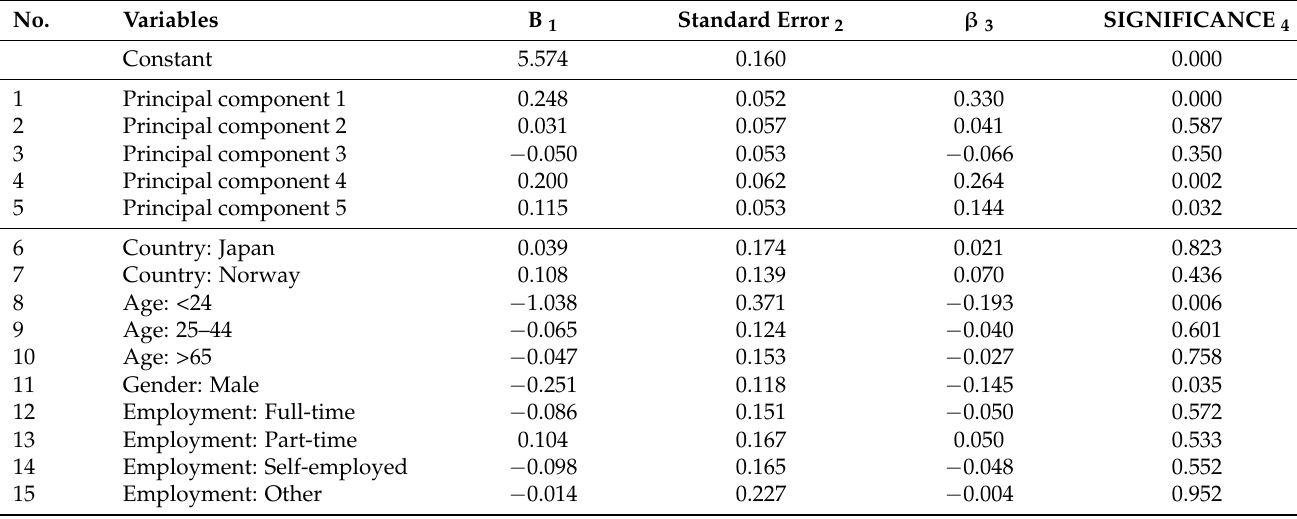
Table 5. Results of the multiple linear regression ( n =